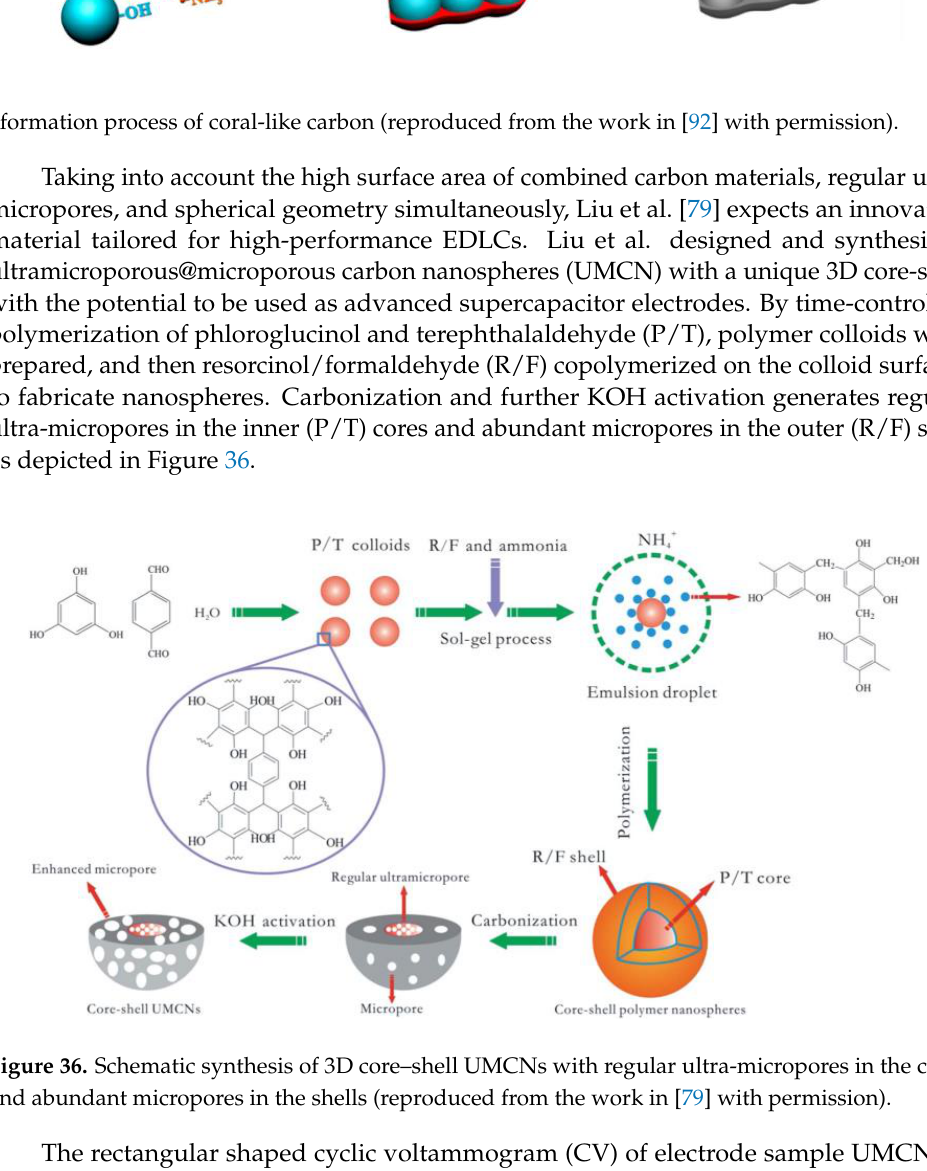
Figure 37. CV scan of UMCN-60 electrode at scan rate of 5 V/s (reproduced from the work in [79] with permission). Resulting unique nanoarchitecture UMCNs exhibit high gravimetric capacitance (411 F/g at current density of 1 A/g), ultra-high rate capability, excellent long term cycle life and high power density (50 kW/kg at 100 A/g) [79]. A uniquely structured asymmetric supercapacitor with excellent performance and low cost was fabricated by Wen and Chen [87]. Asymmetric supercapacitors consist of a negative potential electrode and another electrode that stores energy at a positive poten- tial. Advantages include higher energy and power density due to the larger potential win- dow [87]. Asymmetric supercapacitors have potential applications in renewable-energy technology because of their electrochemical properties. Porous carbons, metal oxides, and conducting polymers are the most commonly used electrode materials for supercapacitors [86]; of metal oxides, ruthenium oxide, cobalt oxide, nickel nitrate, manganese dioxide (MnO 2 ), and vanadium oxide have been used. Among them, MnO 2 has the most ad- vantages, as it is non-polluting, has high theoretical specific capacitance, is abundant, and has easily controllable morphology and structure. Wen and Chen [87] prepared MnO 2